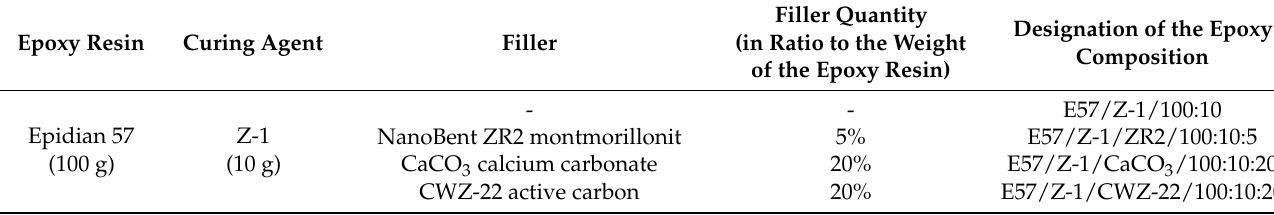
Table 2. Amount of ingredients and designation of adhesive compositions used in the tests.